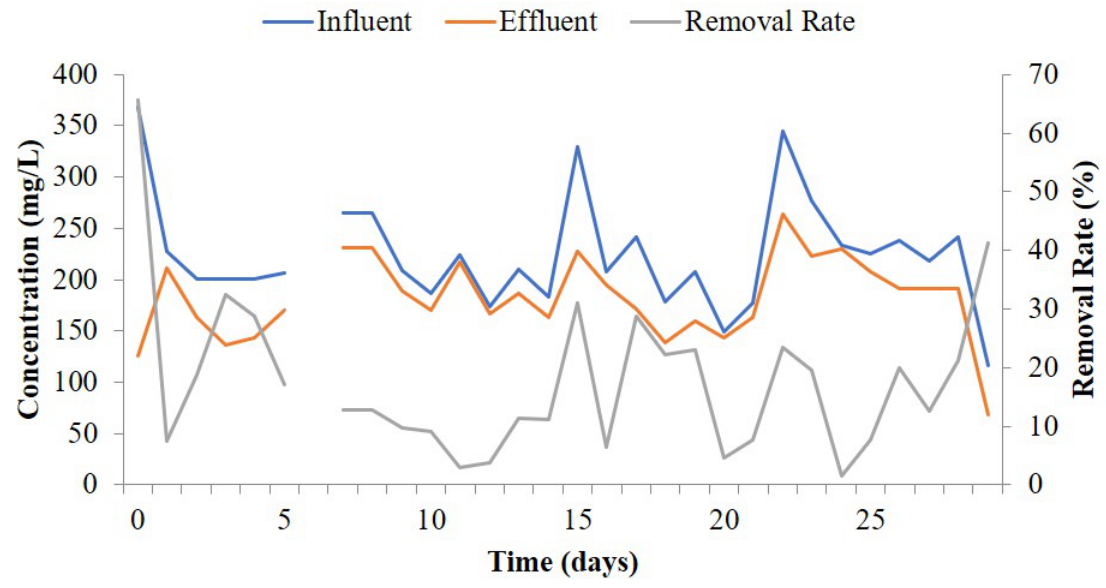
Figure 3. ABR treatment performance during start-up